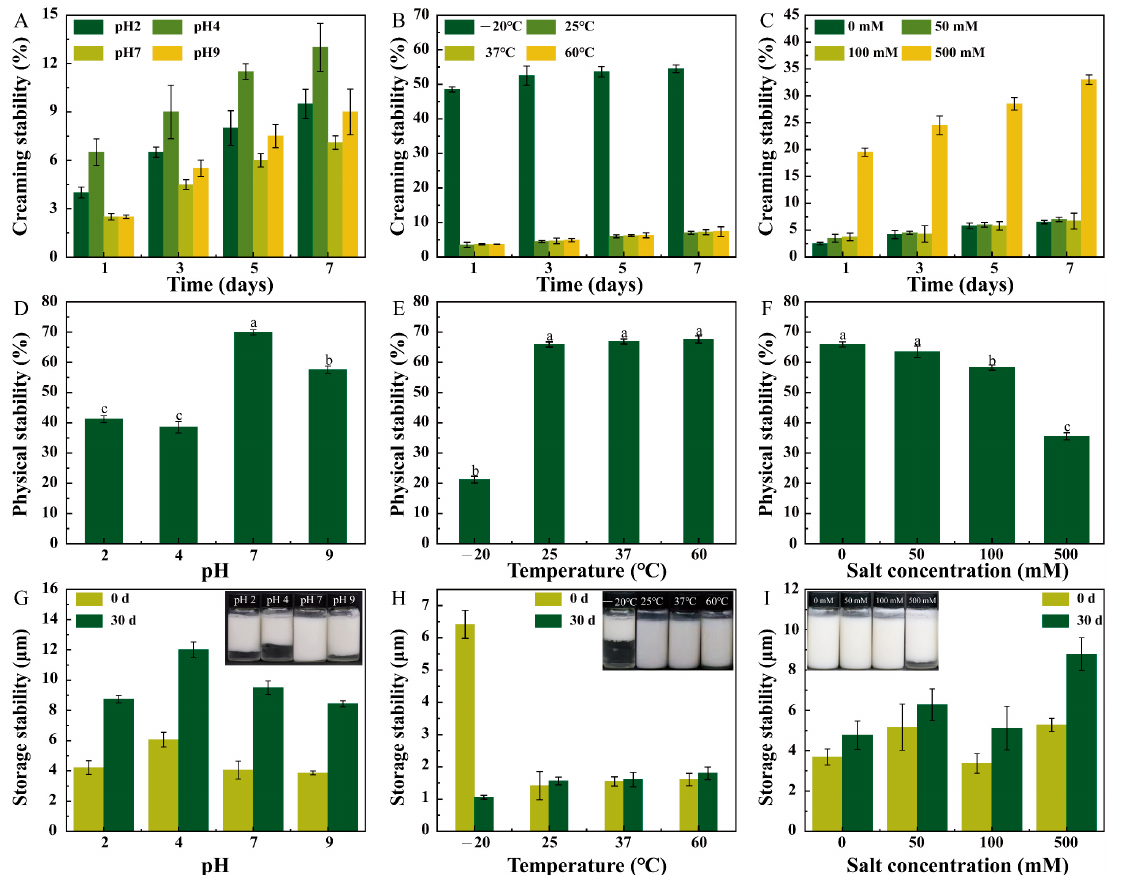
Figure 5. Physical stability of the Pickering emulsion under different environmental stresses. ( A – C ) creaming index (CI), ( D – F ) physical stability, and ( G – I ) storage stability of the Pickering emulsion under different pH, temperature, and salt concentration conditions. Different letters indicate significant differences ( p < 0.05).